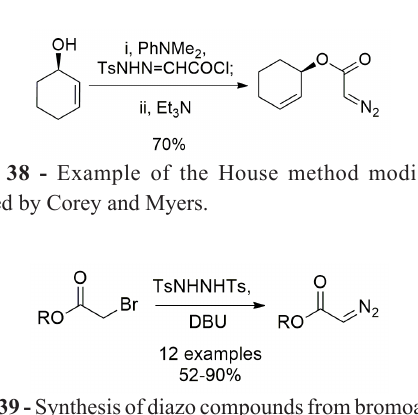
Figure 37 - Reaction described by House for the synthesis of α-diazoesters.